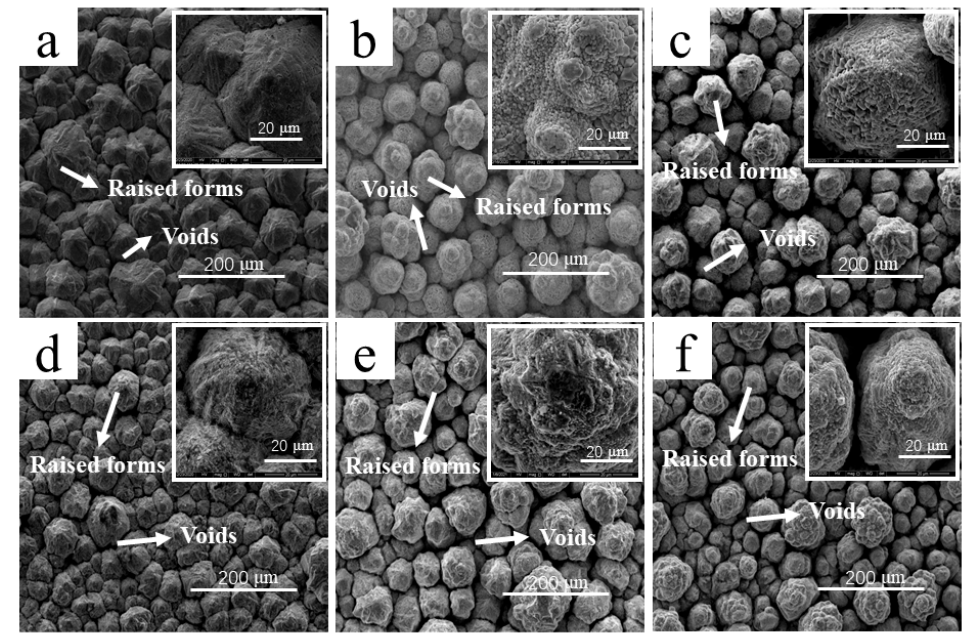
Figure 8. The microscopic morphology of the cathode copper with different Cd 2+ concentrations in the second stage of the cyclone electrowinning process: ( a ) 0 g/L, ( b ) 2 g/L, ( c ) 3 g/L, ( d ) 4 g/L, ( e ) 5 g/L, and ( f ) 6 g/L.